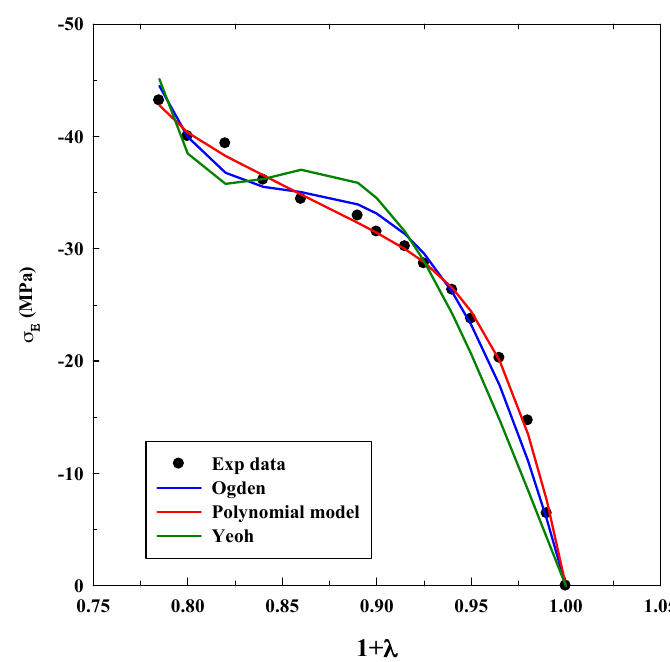
Figure 11. Fitting of compression tests for the system CA loaded with 9% w / w GO using different models.